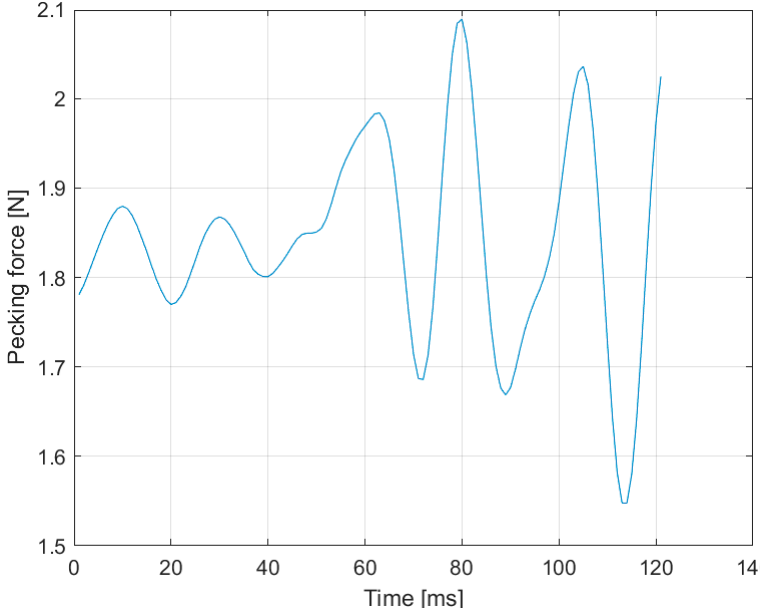
Figure 5. Pecking force at 120 ms.